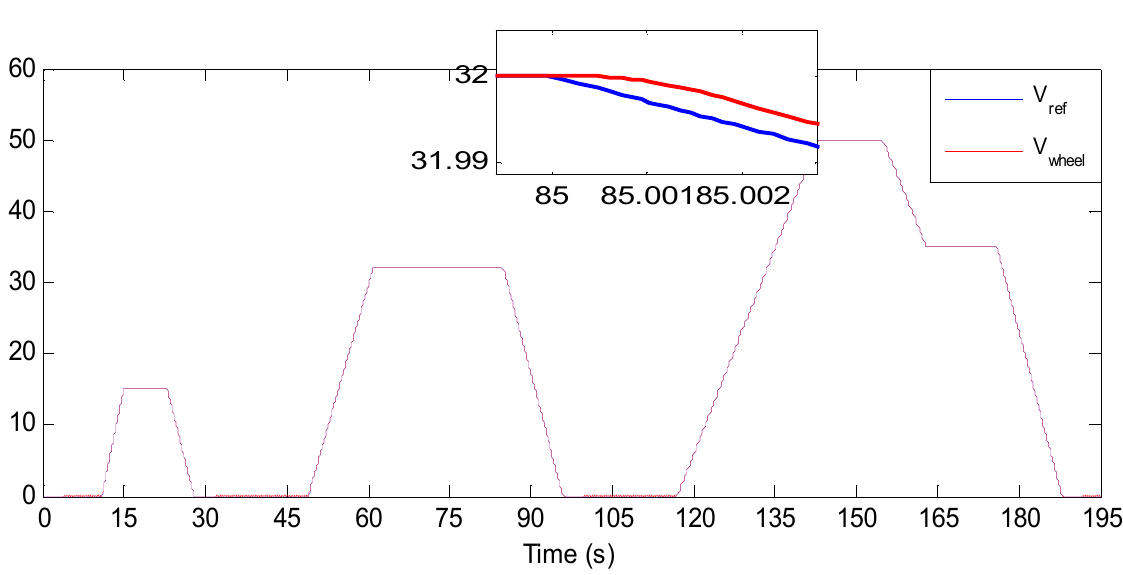
Figure 26. BEV speed absolute error for ECE driving cycle.